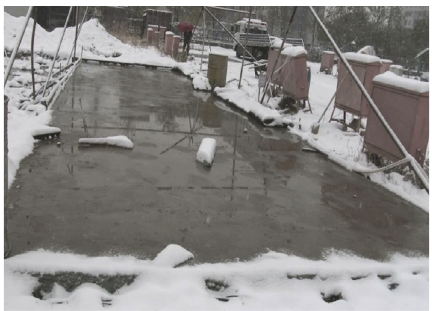
Figure 10: Snow melting performance of heat pipe pavement on 22 November